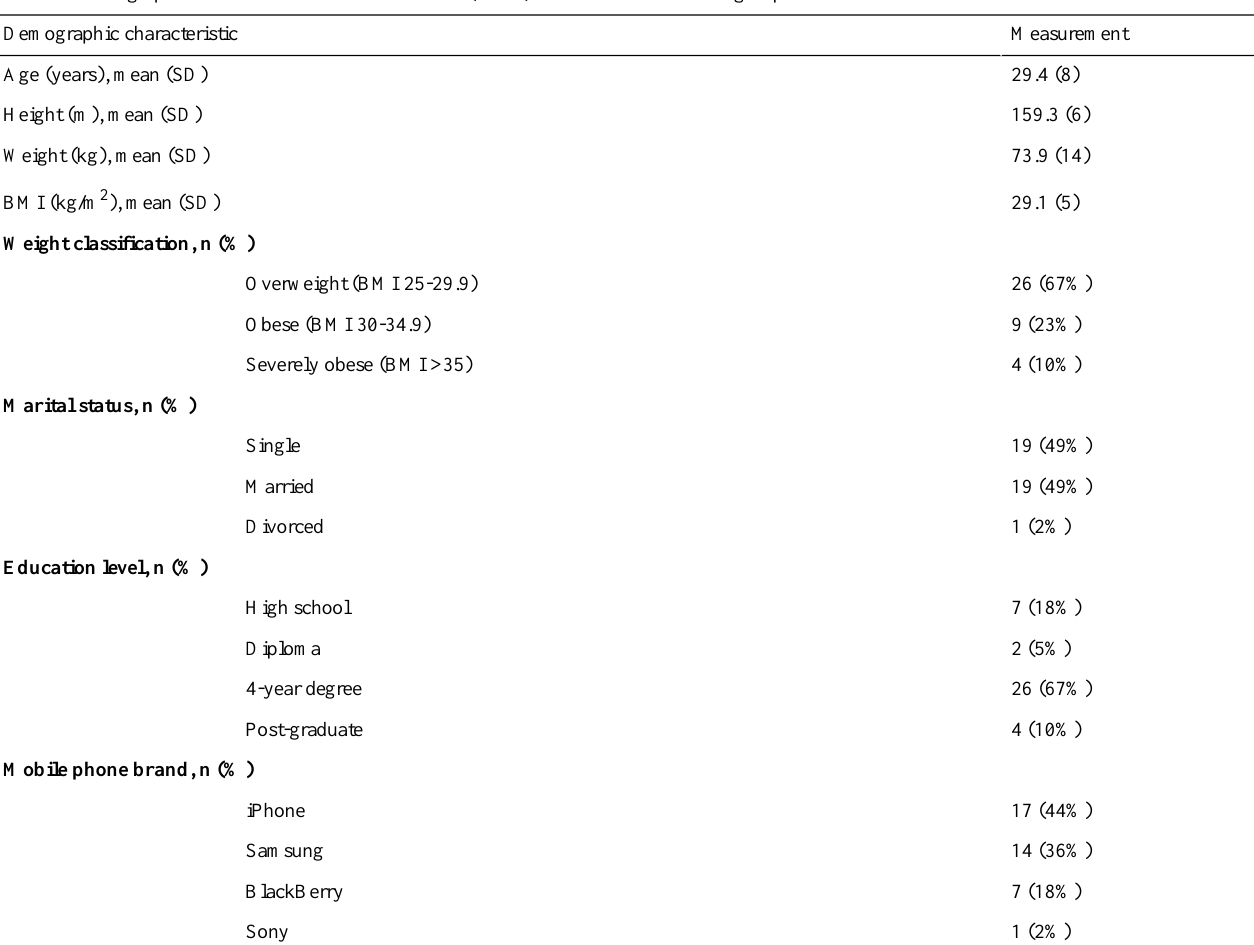
Table 1. Demographic characteristics of Saudi women (N=39) involved in the 4 focus